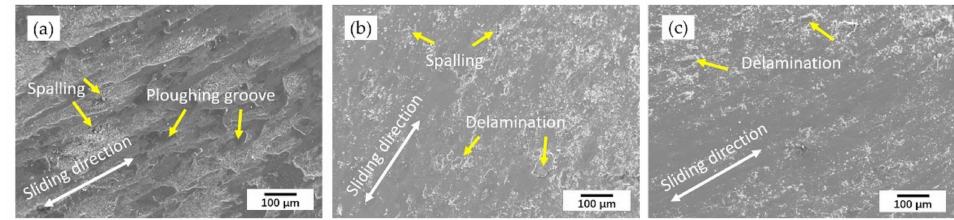
Figure 13. Friction and wear topography of samples: ( a ) SS316 Substrate; ( b ) 55 NiTi coating; ( c ) 55 NiTi + 5 Ni coating.